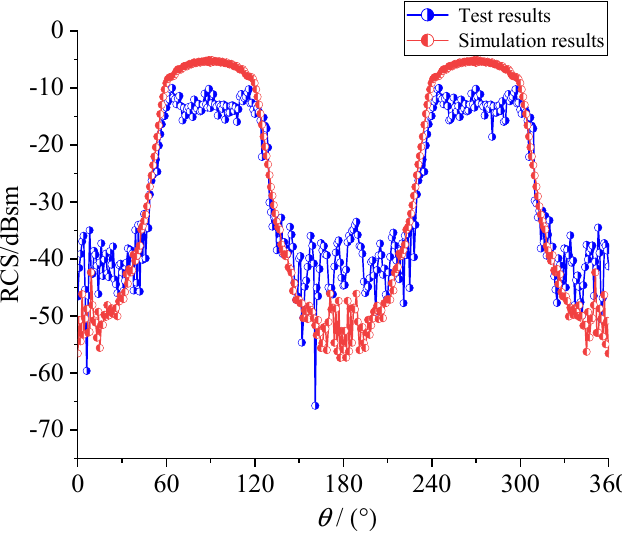
Figure 8. Comparison of RCS test and simulation results.